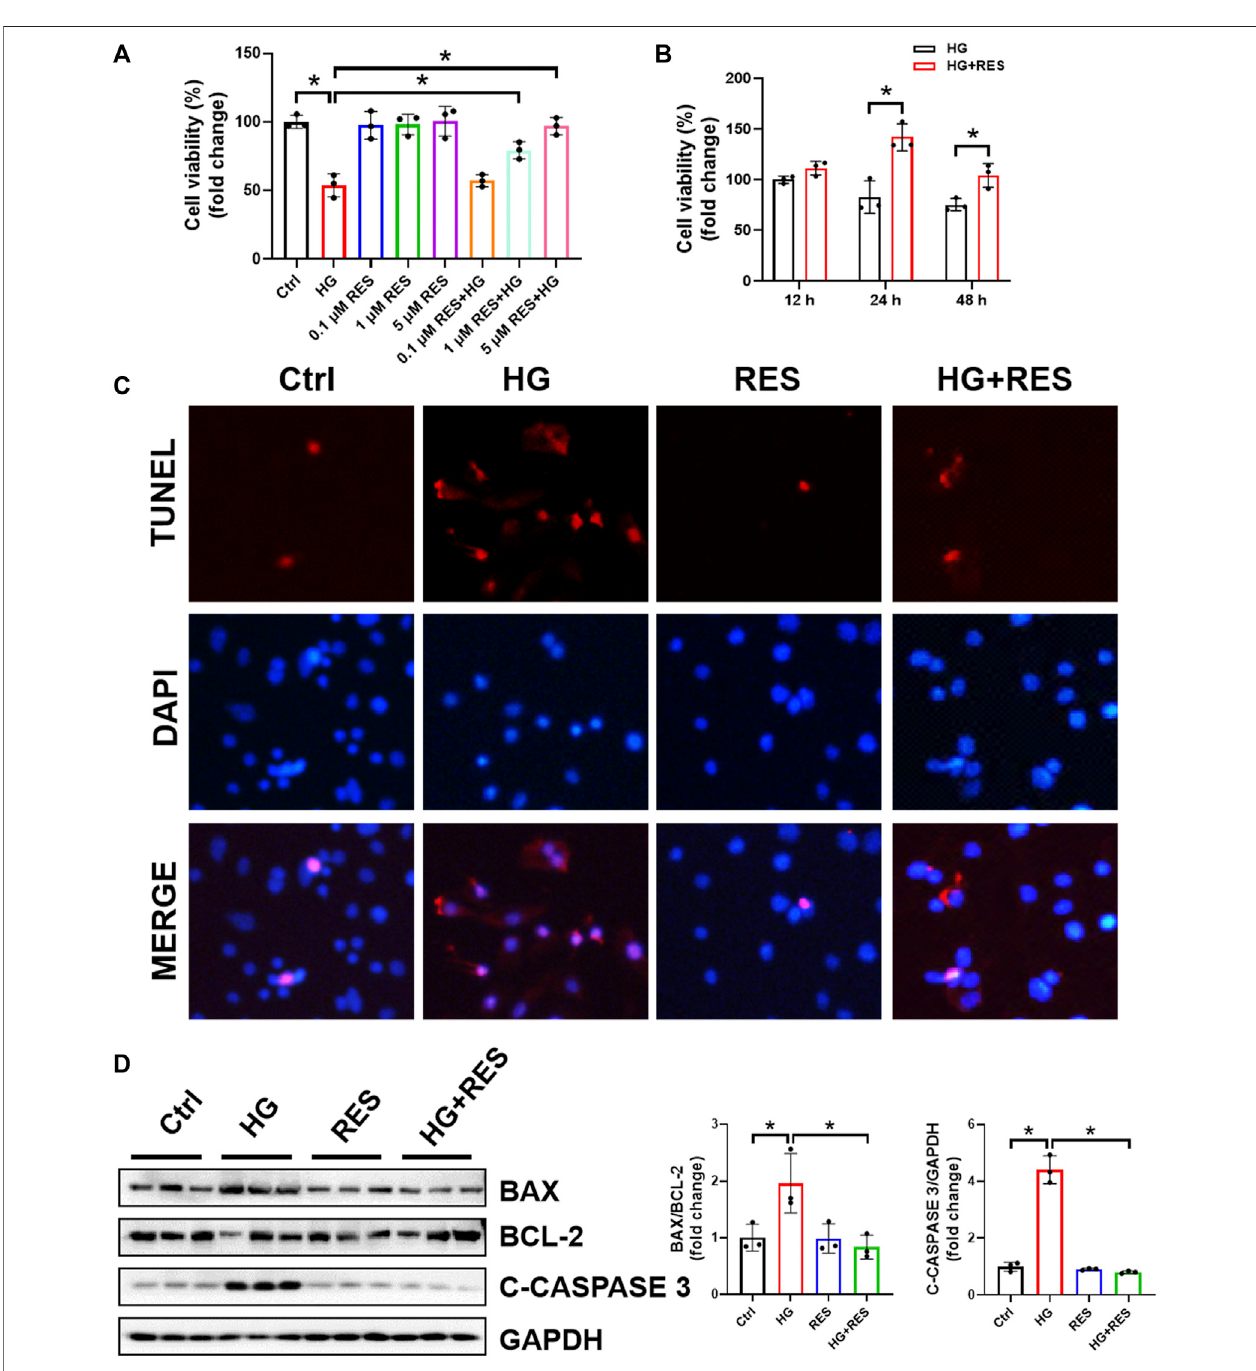
FIGURE1| Resveratrol(RES)reversedhighglucose-(HG-)inducedinhibitionofcellviabilityandapoptosisinMC3T3-E1cells. (A) MC3T3-E1cellswereincubated withorwithout HG(30 mM) and RES(0.1, 1,and 5 μ M) for24 h.Cell Counting Kit8wasused tomeasure cellviability. Three independent experiments were performed. (B) Cells were treated with HG or HG combined with RES (5 μ M) for 12, 24, or 48 h. Cell viability was detected by Cell Counting Kit 8. Three independent experiments were performed. (C) Apoptotic cells, cultured in a basic culture medium in the presence or absence of 30 mM HG and (or) 5 μ M RES for 24 h, were detected by TUNELstaining.DAPIstainingwasusedtoshowthelocationofnuclei. (D) TheexpressionofBAX,BCL-2,andCLEAVED-CASPASE3(C-CASPASE3)wasanalyzedby Westernblotwithdensitometricquanti fi cation.GAPDHasaninternalcontrol.Threeindependentexperimentswereperformed.Dataareshownasmean±SD.* p < 0.05.